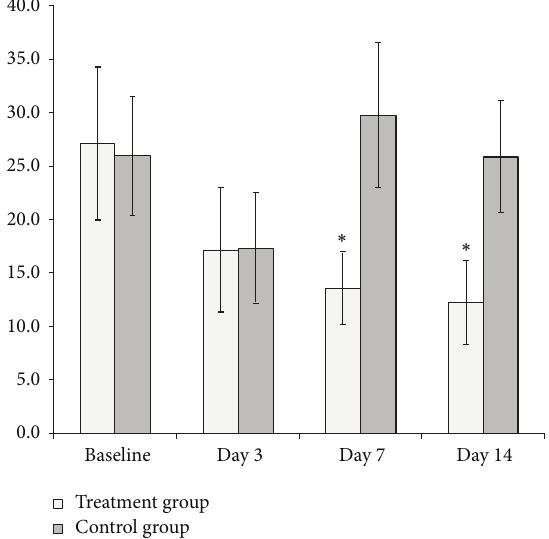
Figure 4: Averaged flow-metabolic ratio (FMR) before and at different time points after bevacizumab therapy. FMR showed a distinct decreasing trend in the treatment group whereas no significant change was identified in the control group. In particular, FMR on day 7 and day 14 significantly decreased compared with baseline.